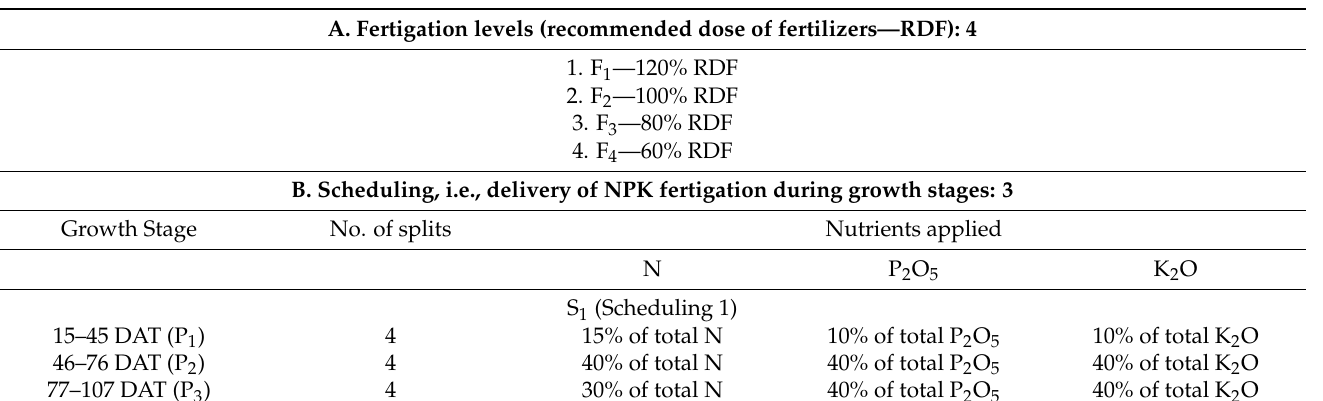
Table 1. Treatment details—four fertigation levels (A) and three fertigation scheduling